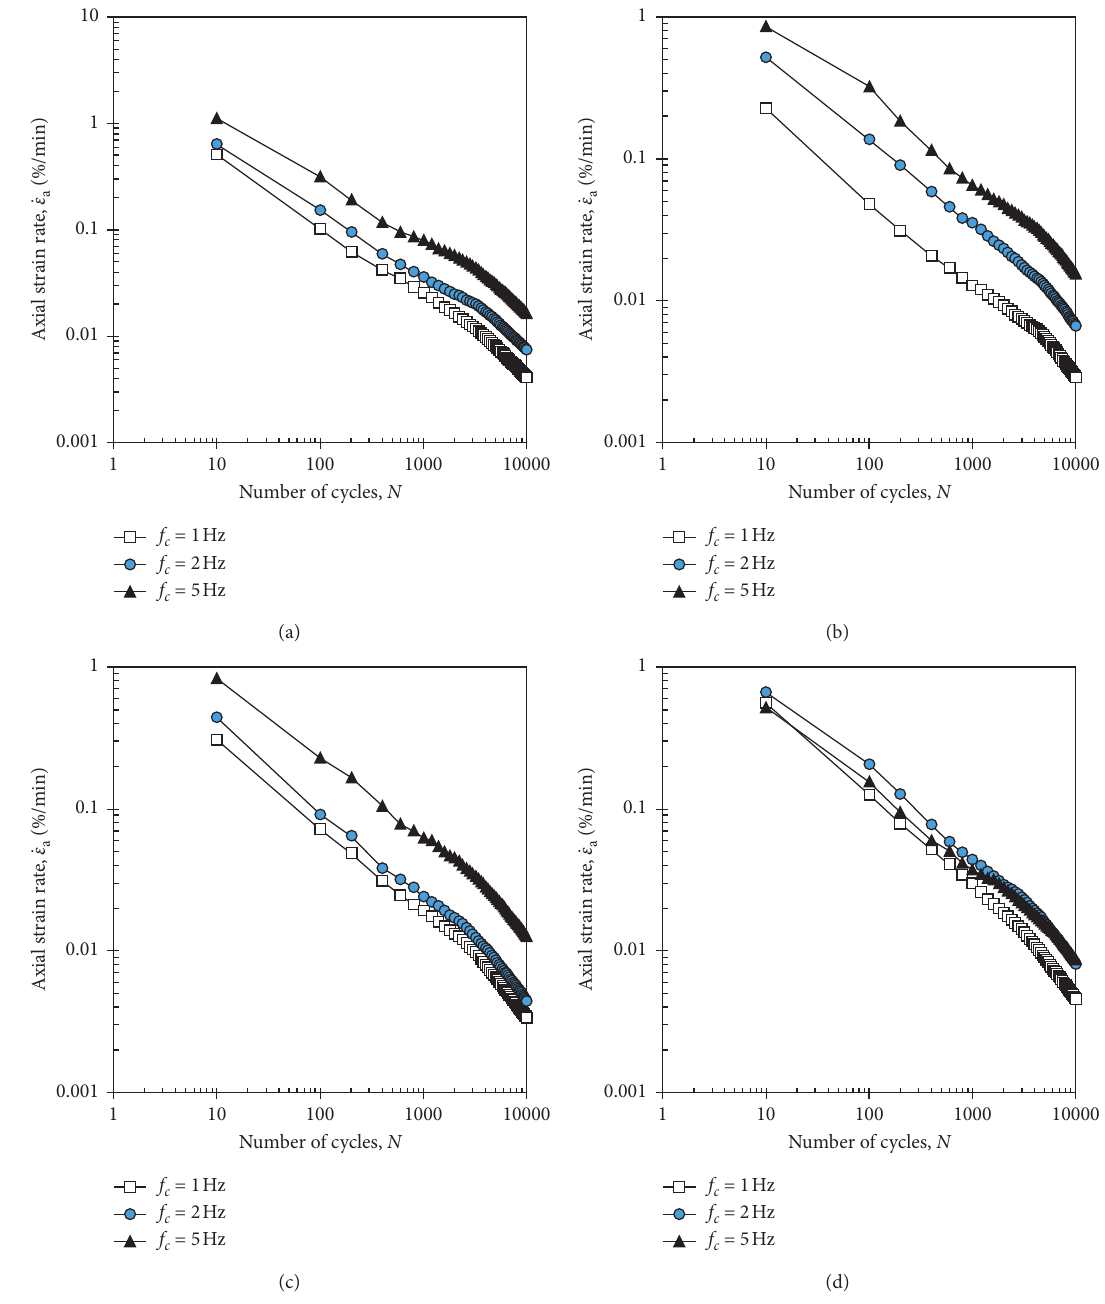
Figure 10: Variation of _ ε a with N at f v of (a) 0Hz, (b) 1Hz, (c) 2 Hz, and (d)